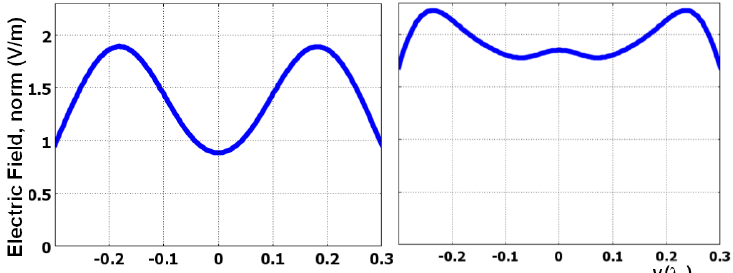
Figure 4. Electric field at 0.02 λ 0 from the dielectric surface for cases (a) and (d) in Figure 3 (left and right panels, respectively).